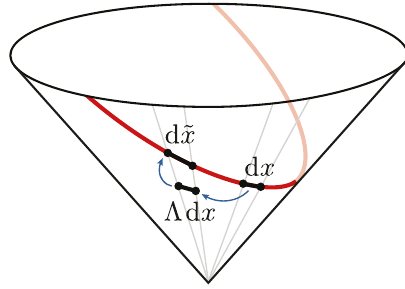
Figure 3. Illustration of the action of Lorentz transformations (and re-scalings) on points living on the Euclidean section of the lightcone in embedding